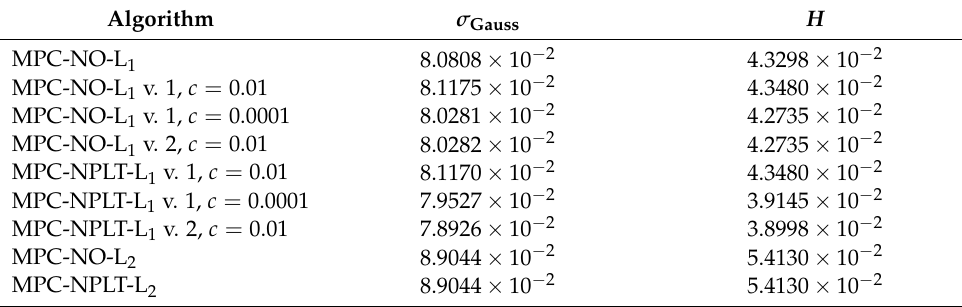
Table 3. Simulation results: σ Gauss and H